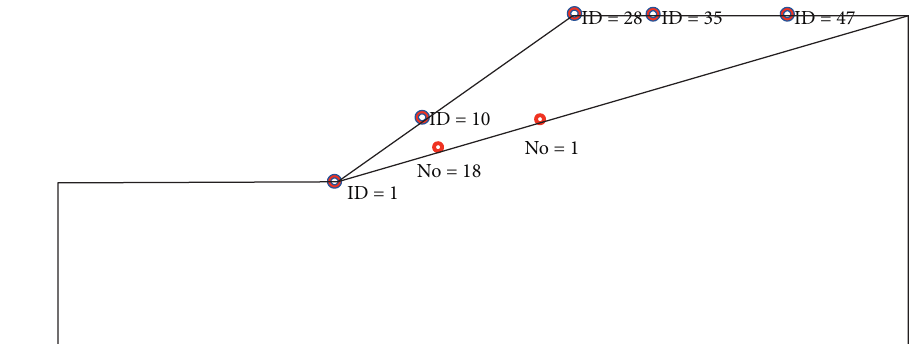
Figure 10: Distribution of calculation points.